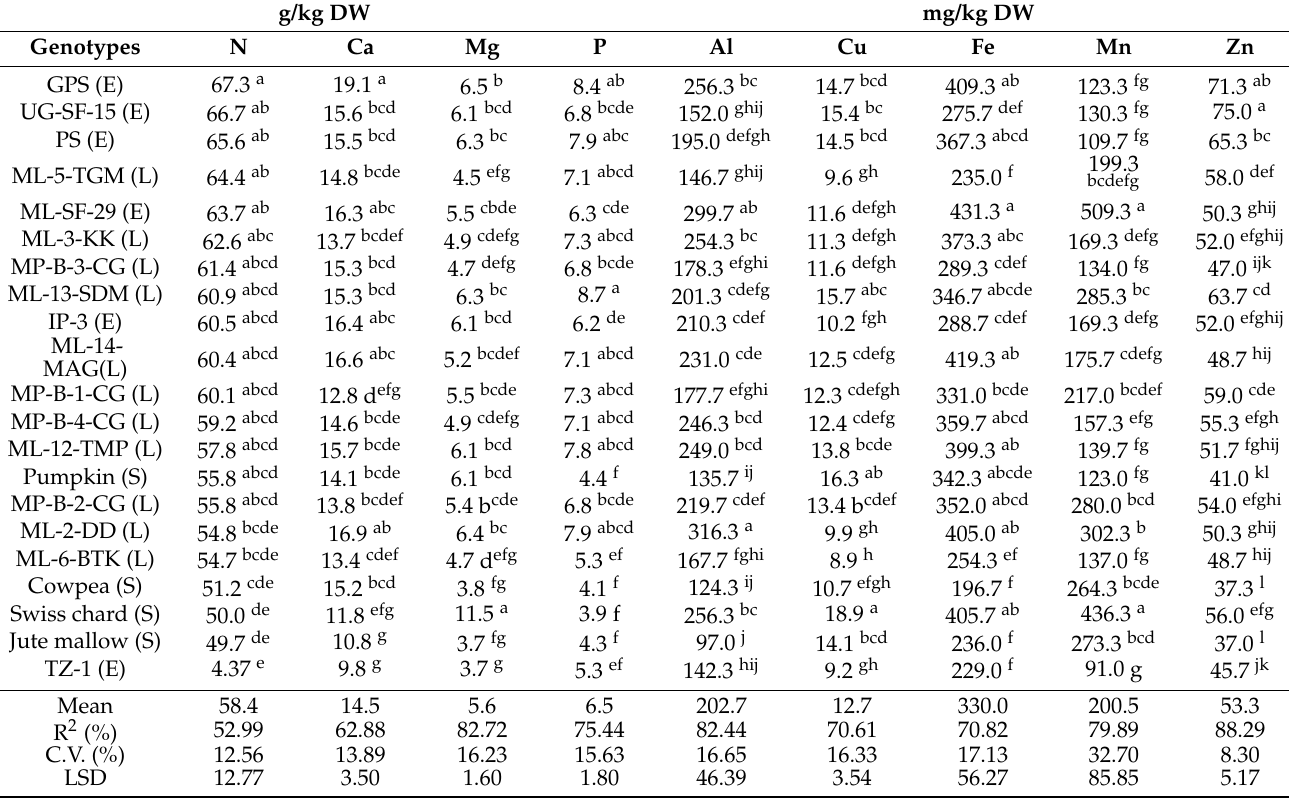
Table 1. Mineral content of exotic and local genotypes of spider plant and four standards (swiss chard, pumpkin, cowpea, and jute